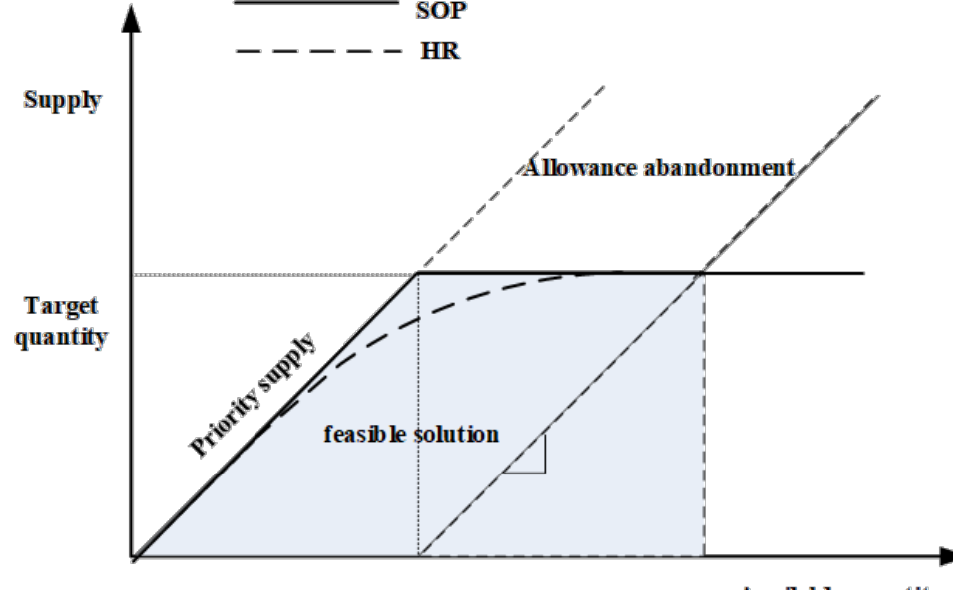
Figure 1. Standard operating policy (SOP) and hedging regulation (HR).